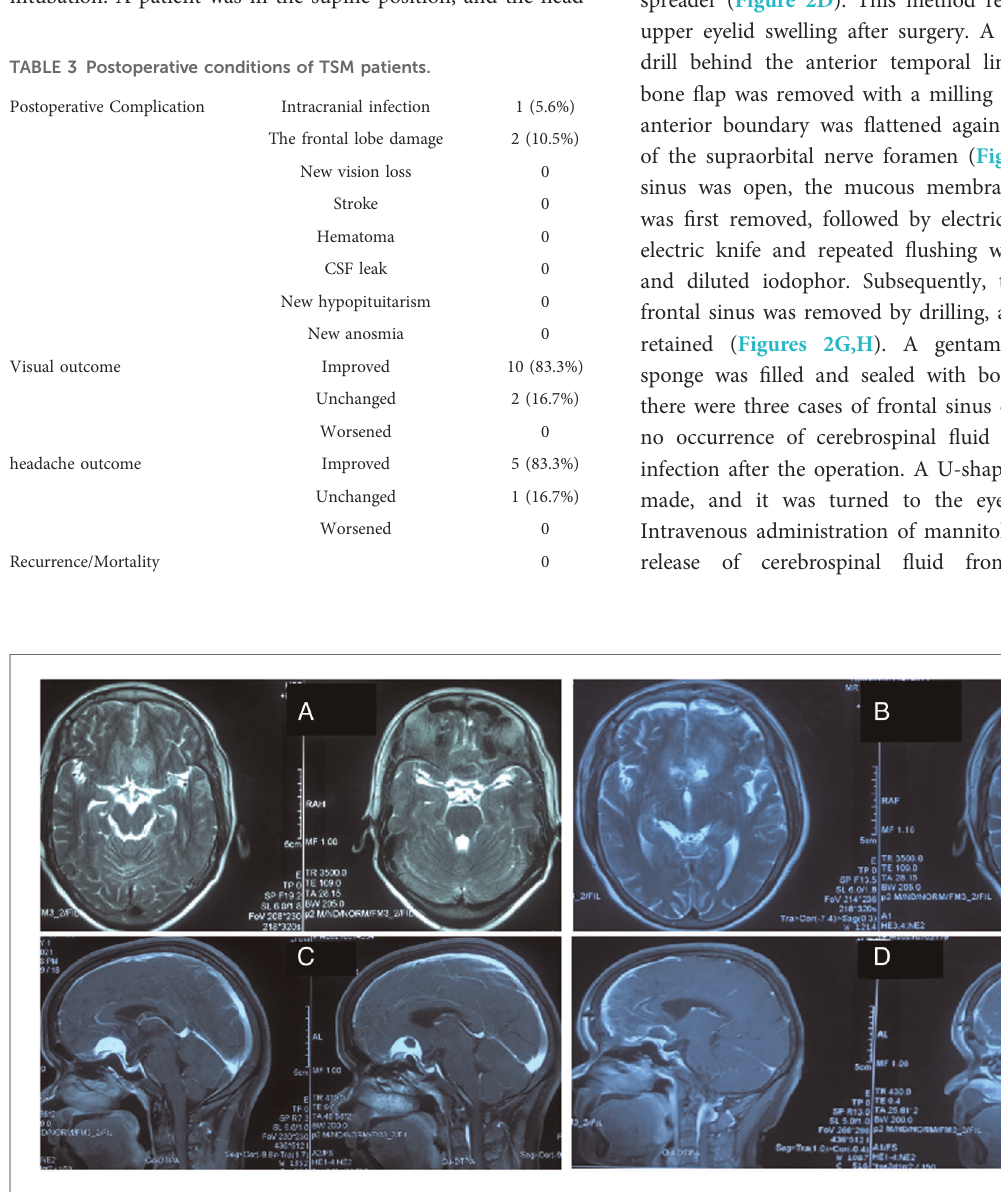
FIGURE 1 Magnetic resonance imaging of the patients ( A,C ) Preoperative ( B,D ) postoperative.